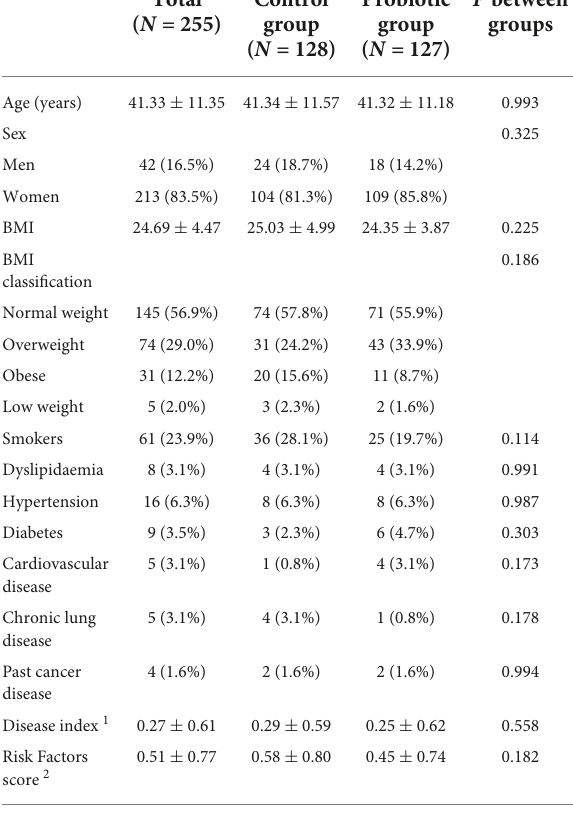
TABLE 1 Baseline characteristics of the subjects participating in the